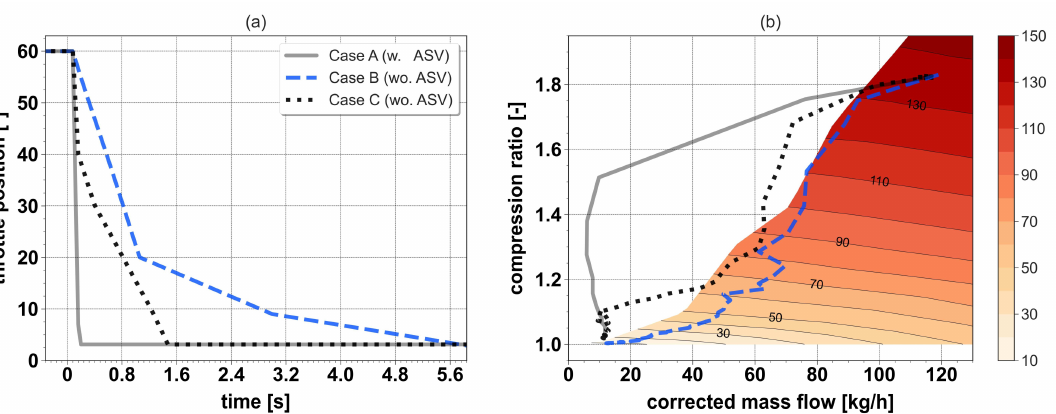
Figure 5. Throttle actuation ( a ) and compressor speed map ( b ) for Cases A, B, and C. The corrected compressor speed values are given in